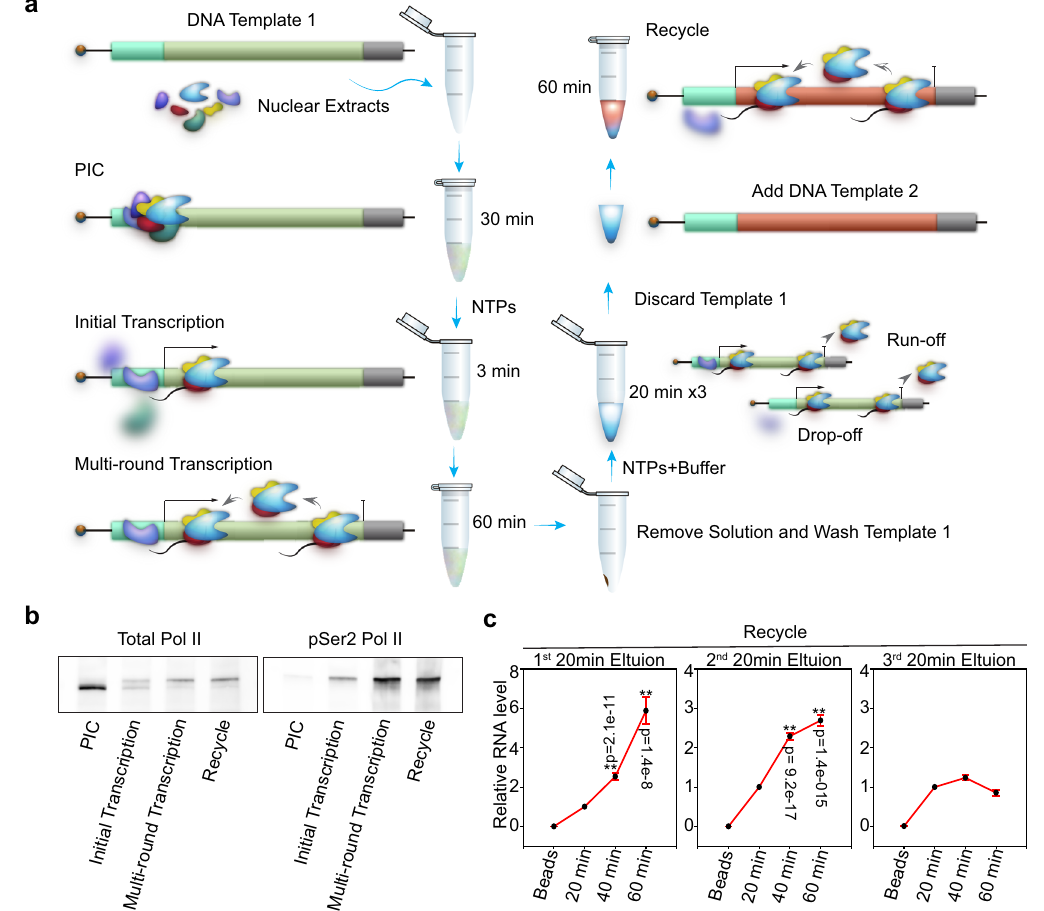
Fig. 1 In vitro transcription recycling system. a Schematic of the in vitro transcription recycling assay. b Western blot analysis of total Pol II and phosphorylated Pol II bound to the template in individual transcription steps. These images are representative of two independent experiments. c In vitro transcribed RNA products from the 2nd template during the Recycle step were analyzed by reverse transcription followed by qPCR quanti fi cation. Values were expressed as the mean ± SEM of three independent experiments. p -values were calculated using two-tailed Student ’ s t -test comparing the 20 min group to other experimental groups, ** p < 0.01. Source data are provided as a Source data fi